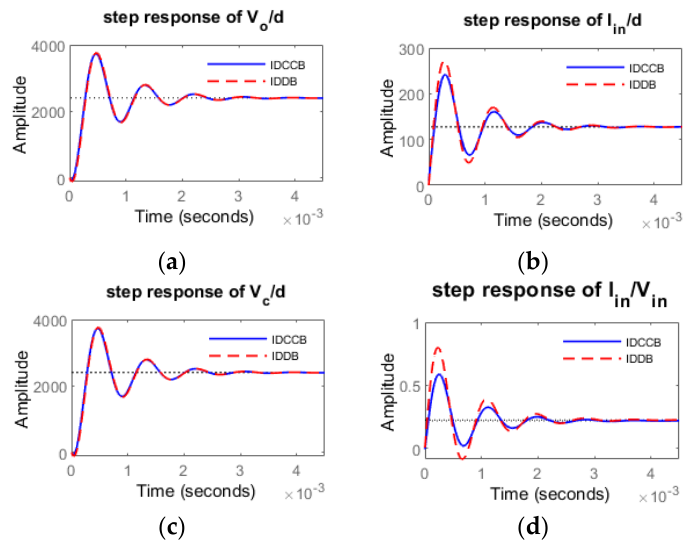
Figure 6. Set of probable equilibrium points: ( a ) output voltage-to-duty ratio ( V o / d ); ( b ) input current-to-duty ratio ( I in / d ); ( c ) capacitor voltage-to-duty ratio ( V c / d ); ( d ) input current-to-input voltage ( I in / V in ) transfer functions of the IDDB and IDCCB.